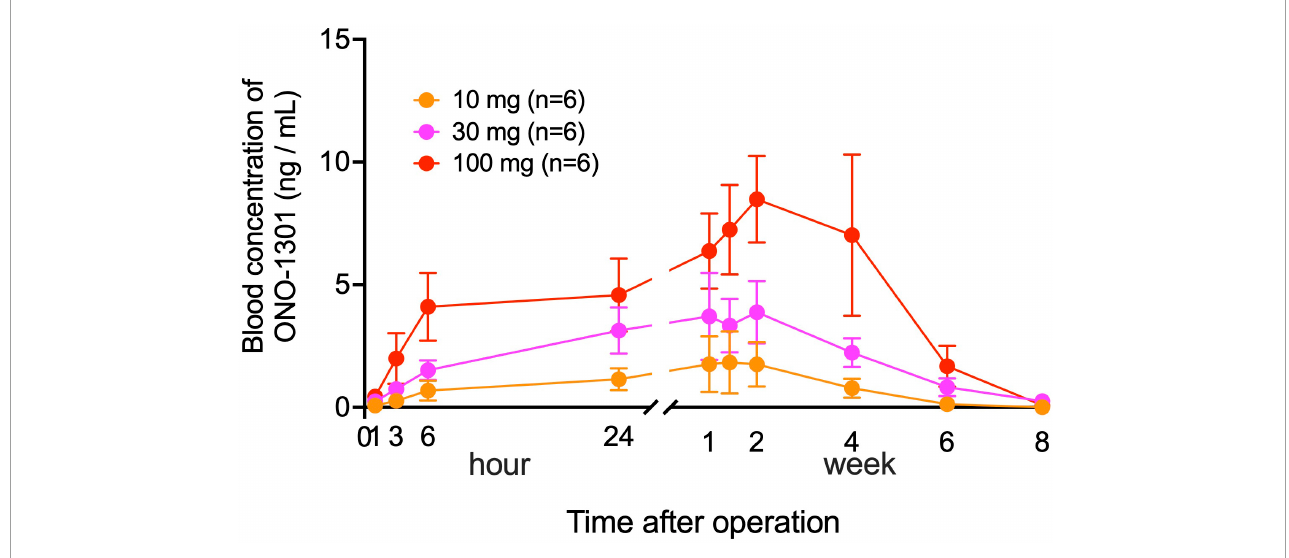
FIGURE1 Serial changes in blood concentration of ONO-1301. Serial changes postoperatively in the blood concentration of ONO-1301 in each group (10-mg YS-1402, 30-mg YS-1402, and 100-mg YS-1402). The data are presented as the mean ± the standard